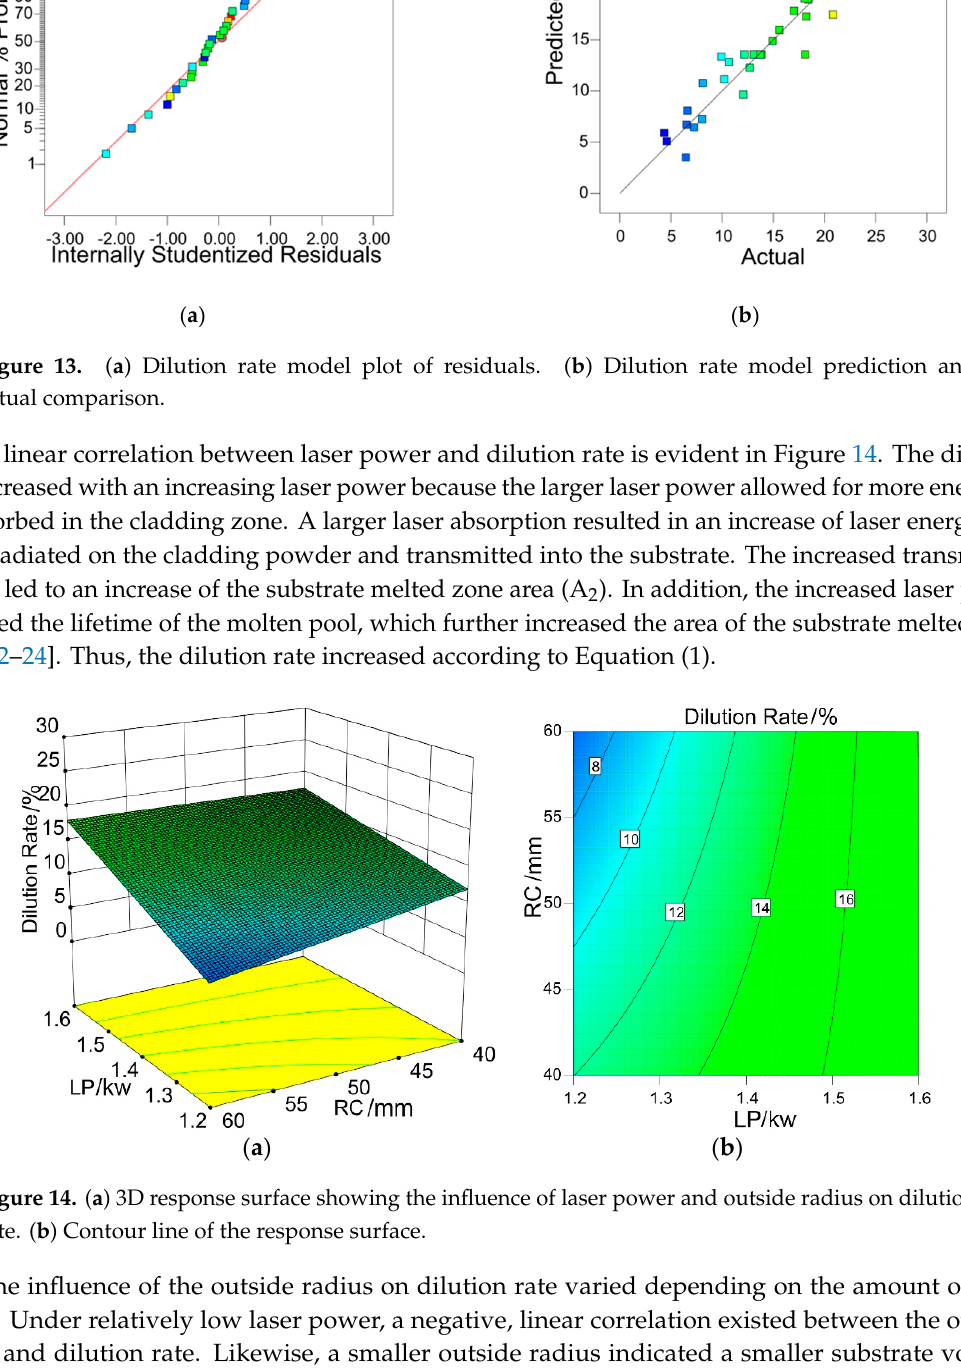
Figure 14 . ( a ) 3D response surface showing the influence of laser power and outside radius on dilution rate. ( b ) Contour line of the response surface.